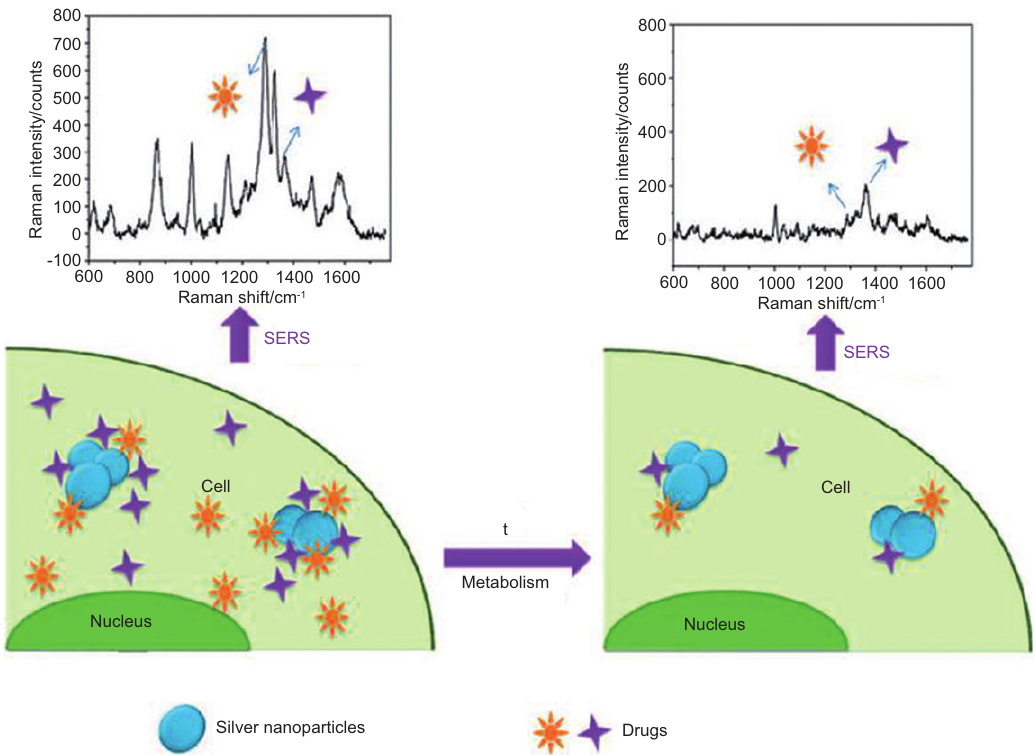
Figure 14 Illustration of the living cell system containing AgNPs and both 6MP and MMI drugs with SERS spectra collected every 30 s